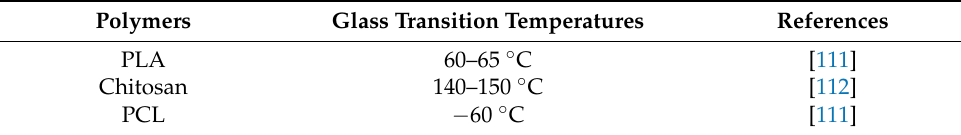
Table 6. Glass transition temperatures (T g ) of anhydrous polymer materials.